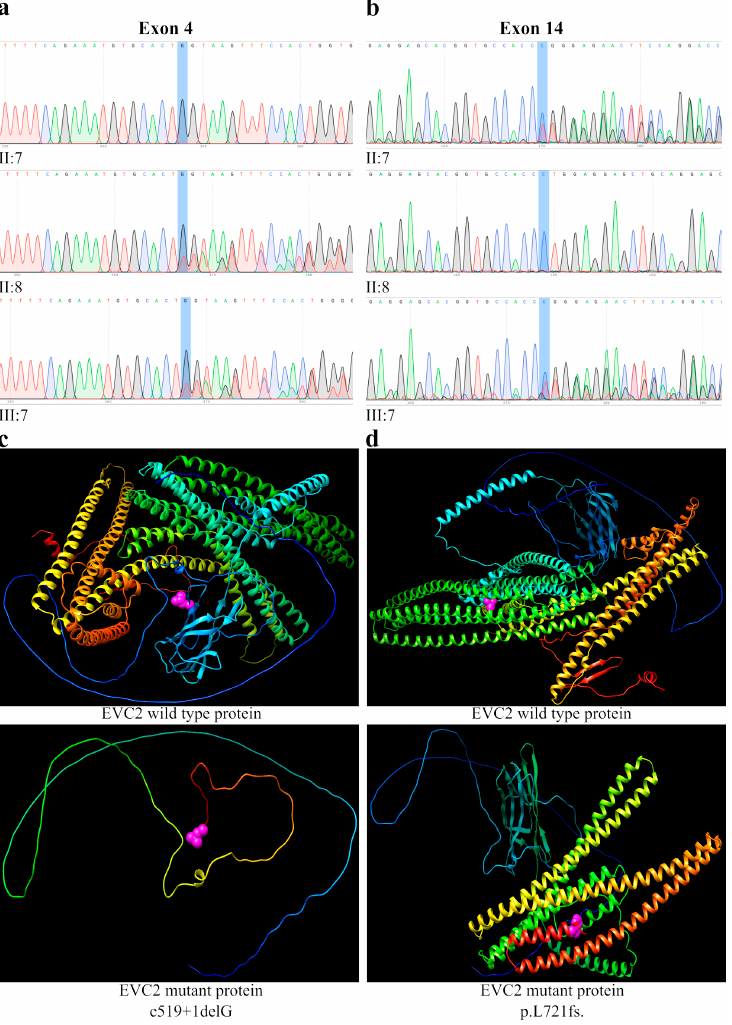
Figure 3. The results of the genetic analysis in the EVC2 gene in a pedigree with EvCS. ( a ) The results of Sanger sequencing of exon4, the patient (electropherogram III:7) and her mother (electropherogram II:8) share a heterozygous donor splice site variant of EVC2 : c.519_519 + 1delinsT.